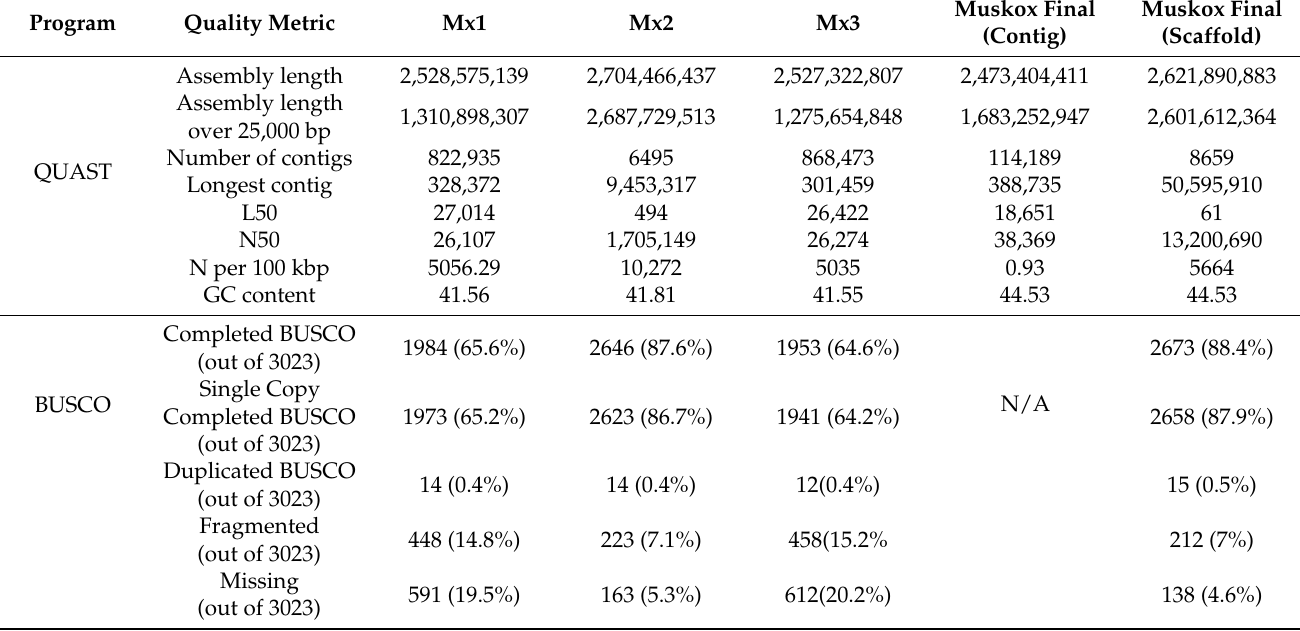
Table 1. Comparison of quality metrics for genome assemblies pre- and post-cross-species-scaffolding and pre- and post-mitochondrial read filtering. Mx1 is the initial scaffold level assembly prior to both cross-species scaffolding and mitochondrial read filtering; Mx2 is the scaffold level genome assembly after cross-species scaffolding, but prior to mitochondrial DNA filtering; Mx3 is the scaffold level genome after mitochondrial read filtering, but prior to cross-species scaffolding; Muskox Final is the final genome assembly with columns for both contig and scaffold levels of